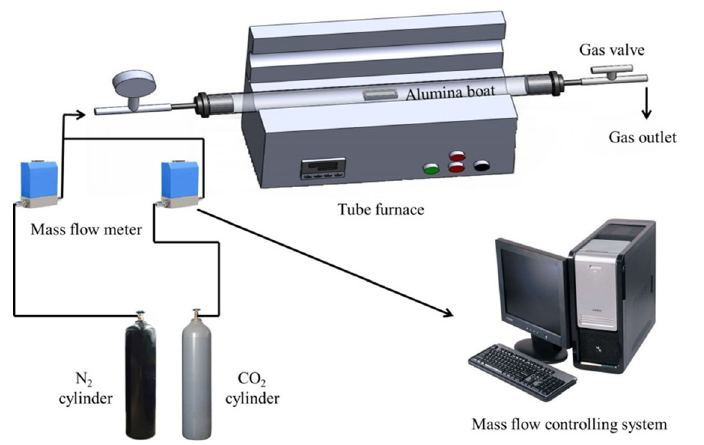
Fig. 1 Schematic diagram of tube